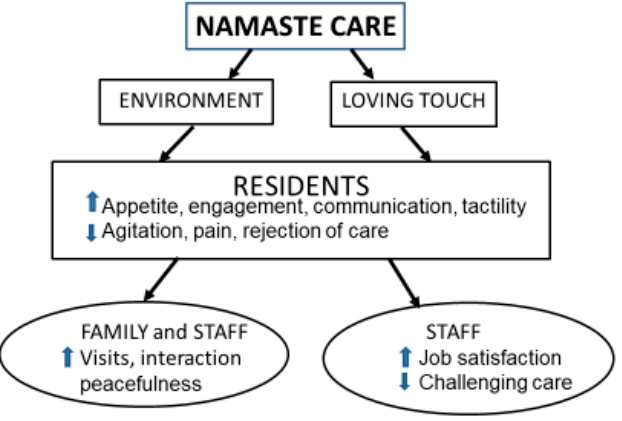
Figure 4. Namaste Care principles and consequences.